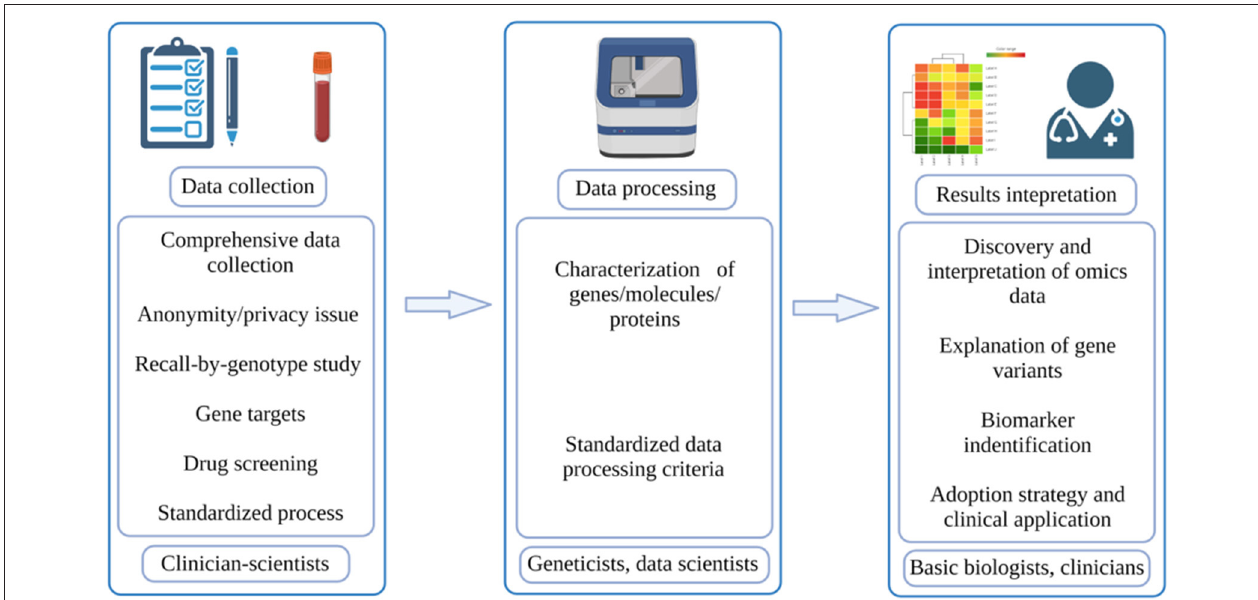
FIGURE 1 | Workflow of PM. The typical workflow of PM involves three parts: data collection, which is done by clinician-scientists; data processing, which is done by geneticists and data scientists; results interpretation, which is done by basic biologists and doctors (created with